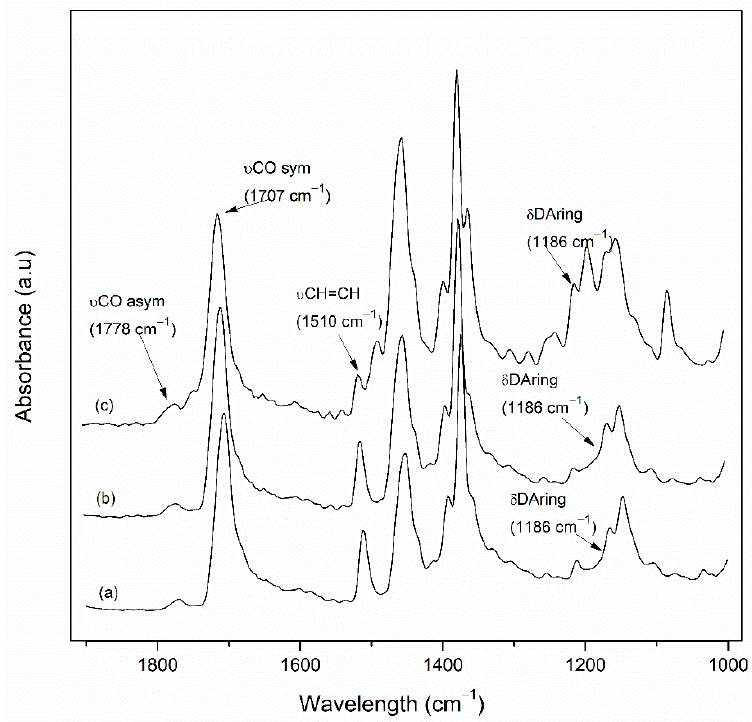
Figure 2. FTIR spectra of FG1 ( a ), FG1A50 ( b ), and FG1A120 ( c ) in the absorption band of 1000–1900 cm − 1 .